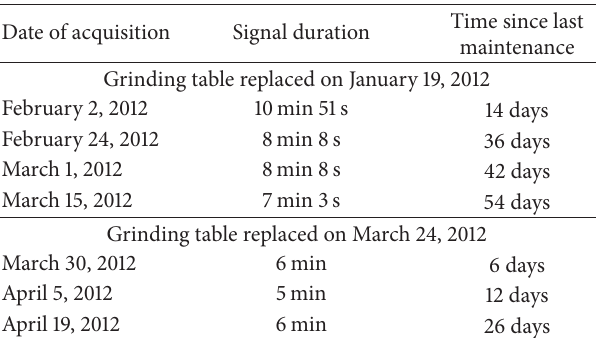
Table 1: Acquired acoustic